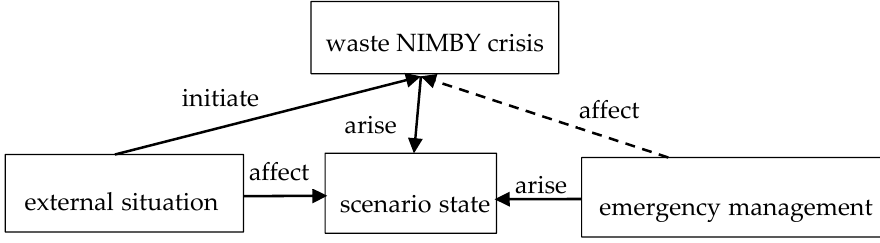
Figure 3. The relationship between the elements of waste NIMBY crisis scenarios.